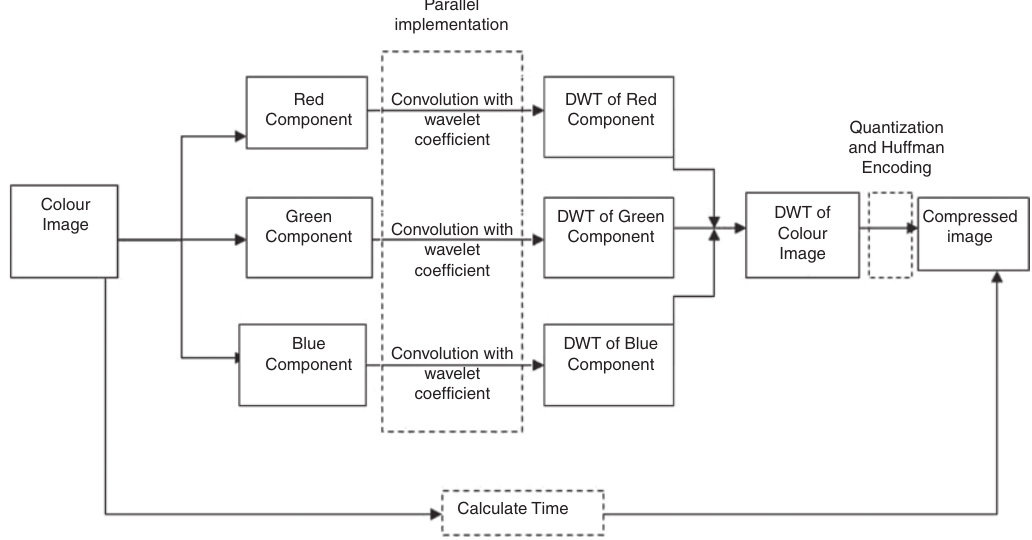
Figure 1: Block Diagram for Color Image Compression using Parallel Image Compression